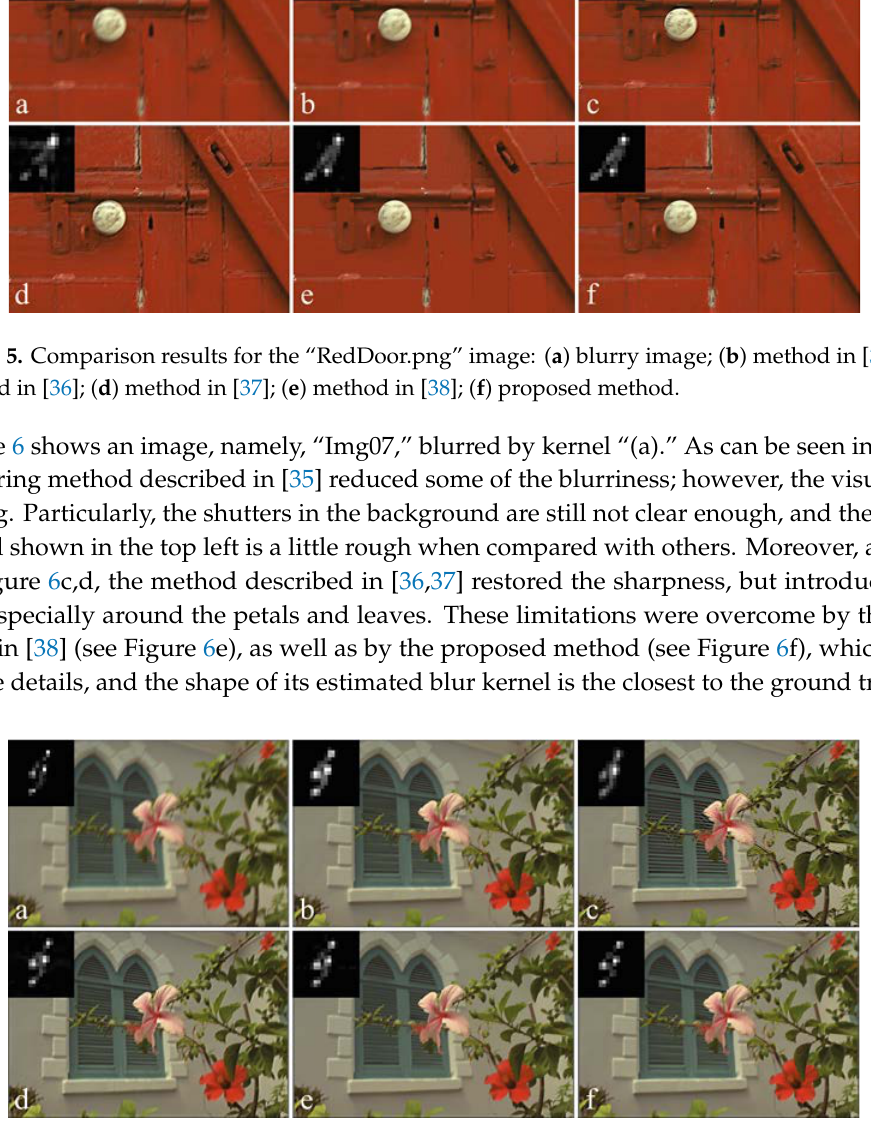
Figure 6. Comparison results for the “Flowers.png” image: ( a ) blurry image; ( b ) method in [35]; ( c ) method in [36]; ( d ) method in [37]; ( e ) method in [38]; ( f ) proposed method.